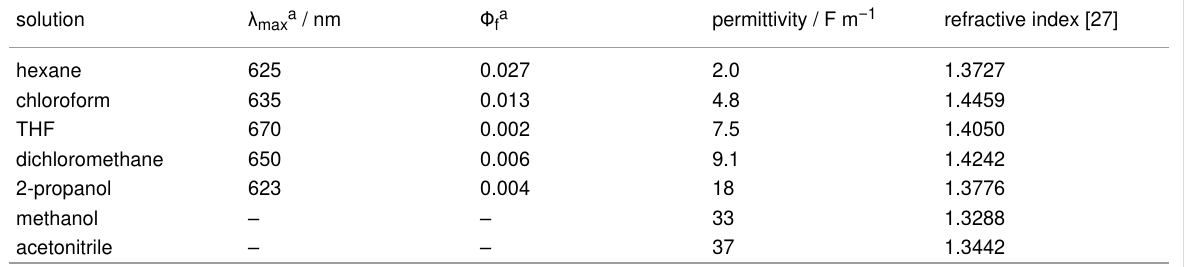
Table 2: Emission maxima of the fluorescence spectra and the relative fluorescence quantum yields Φ f in several solvents. solution